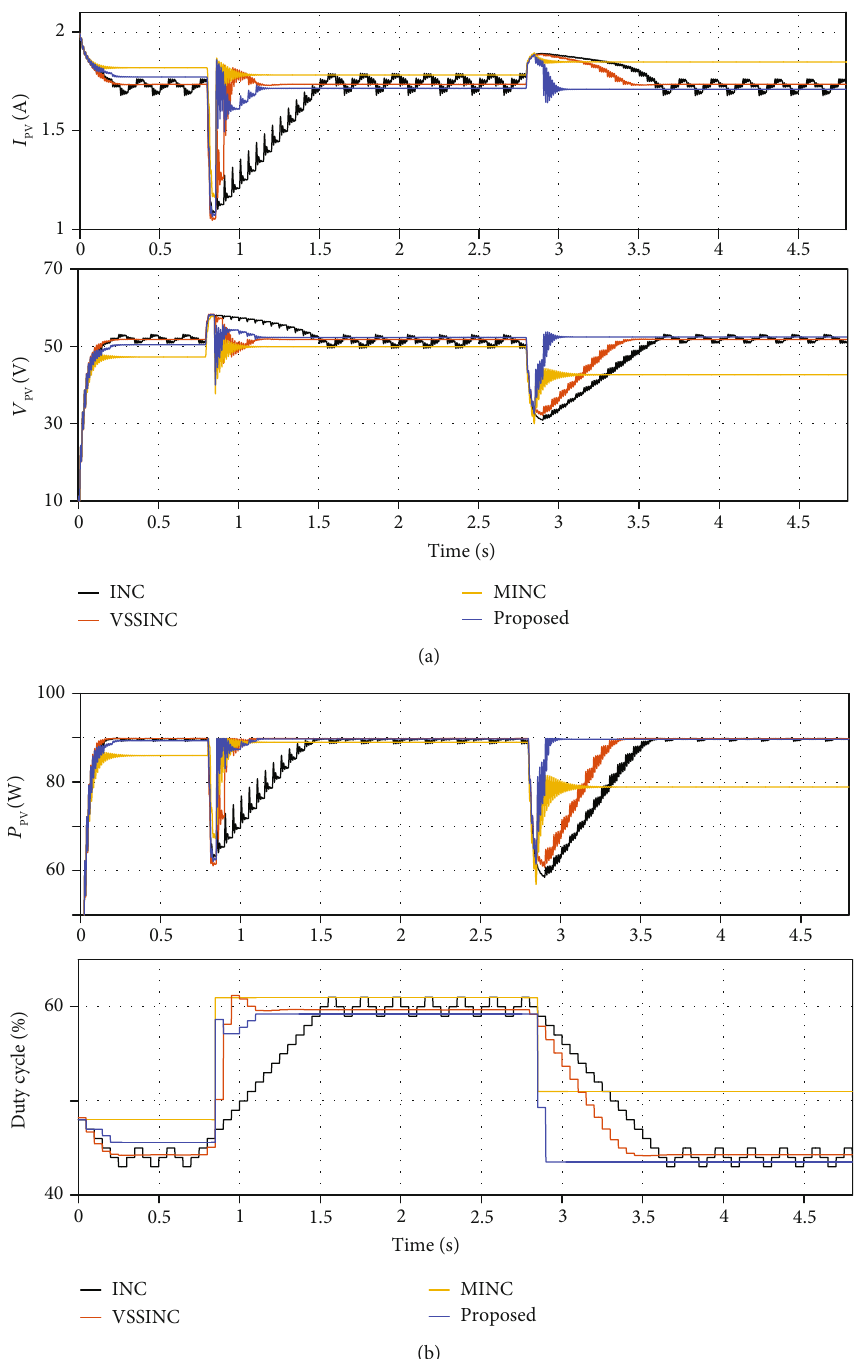
Figure 12: Simulation results of the INC, VSSINC, MINC, and the proposed technique for the load variation condition: (a) current and voltage; (b) power and duty